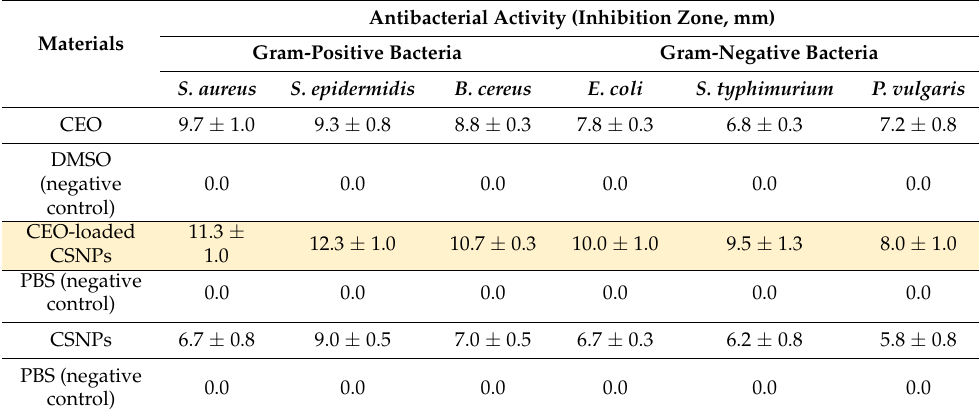
Table 3. Comparison of antibacterial activity of non-encapsulated CEO with